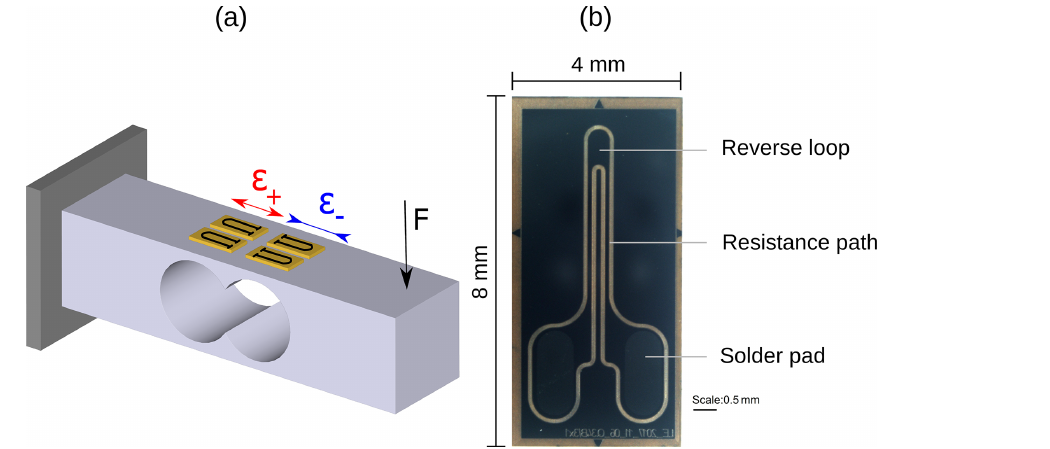
Figure 1. (a) Model of a force transducer consisting of a bending beam and four SGs. An applied force F causes areas of tensile ( (cid:15) + ) and compressive ( (cid:15) − ) strain where the SGs are attached. (b) Microscopic image (front view, mirrored) of a strain gauge produced for this study. The linear structure consists of two straight paths, a reverse loop and two solder pads.